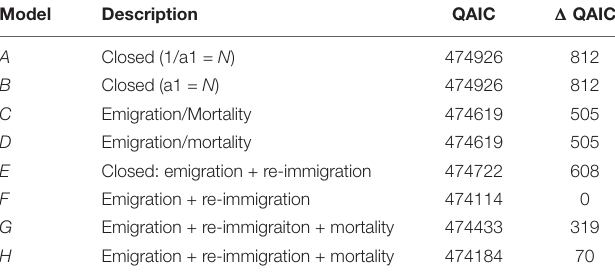
TABLE 4 | Movement models and their fit ( (cid:49) QAIC) to the Lagged Identification Rate of M. alfredi in Coral Bay, Western Australia.